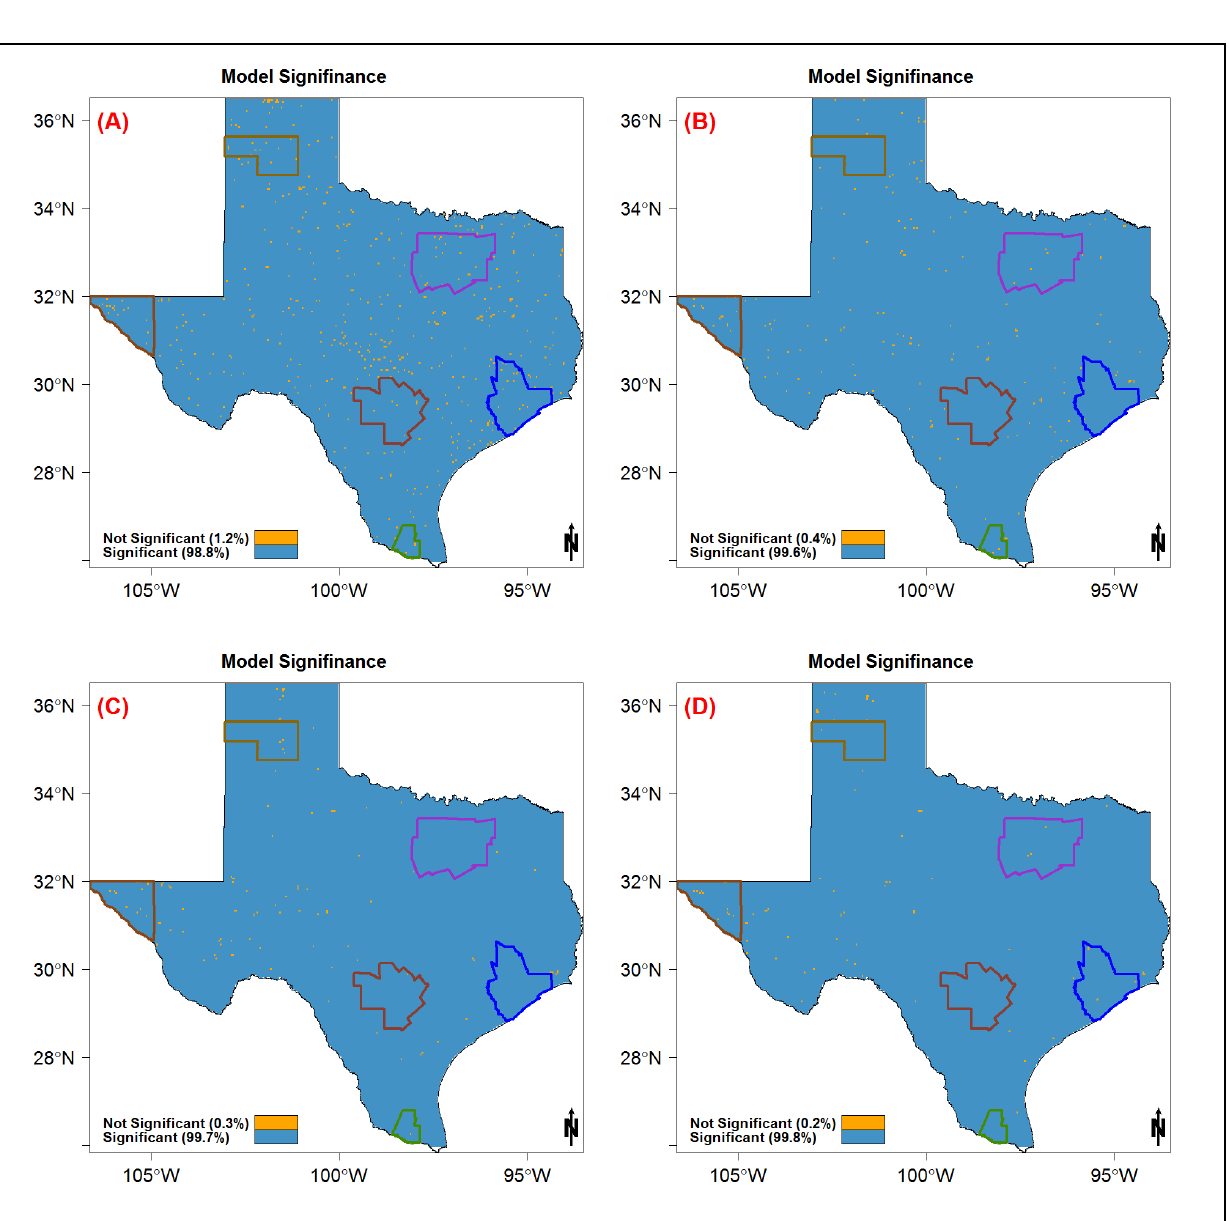
Figure A3. Spatial distribution of the Kolmogorov–Smirnov model of significance test for the Gumbel model distribution for the ( A ) 1-h, ( B ) 6-h, ( C ) 24-h, and ( D ) 48-h storm durations.